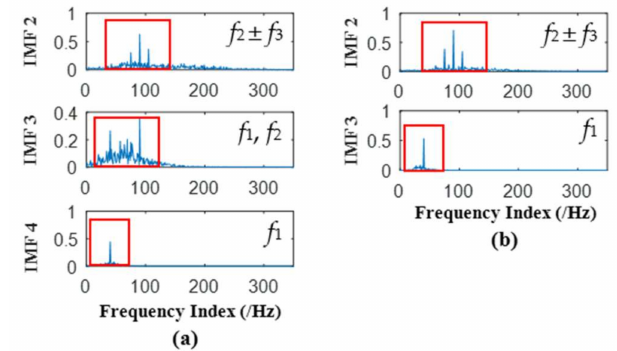
Figure 7. ( a ) Frequency domain plots of IMFs of EMD; ( b ) Frequency domain plots of IMFs of